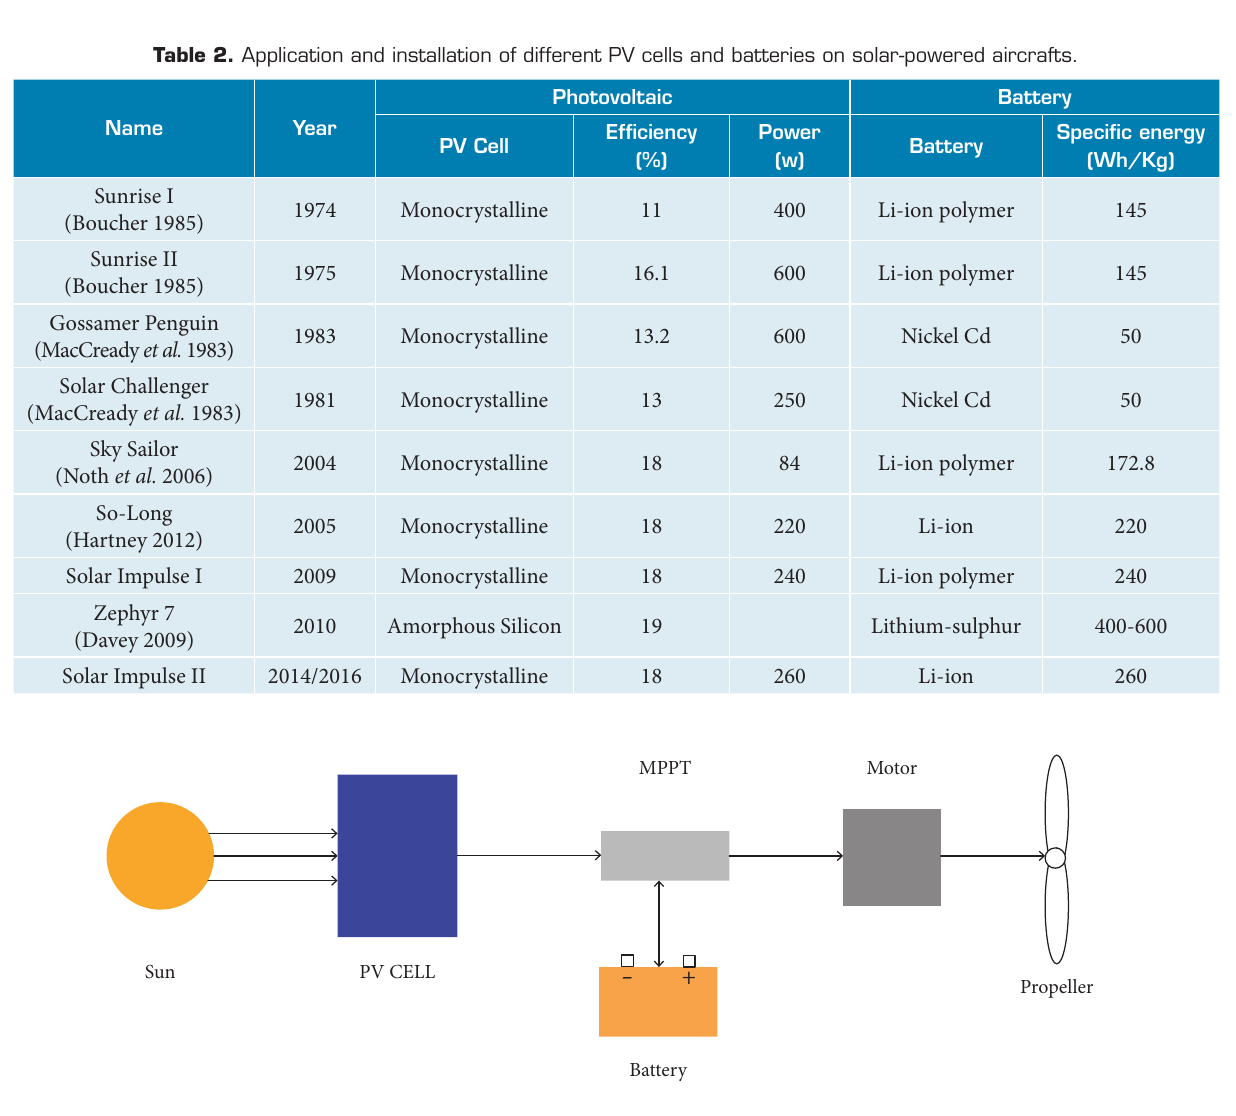
Figure 7. MPPT controller in solar-powered aircraft